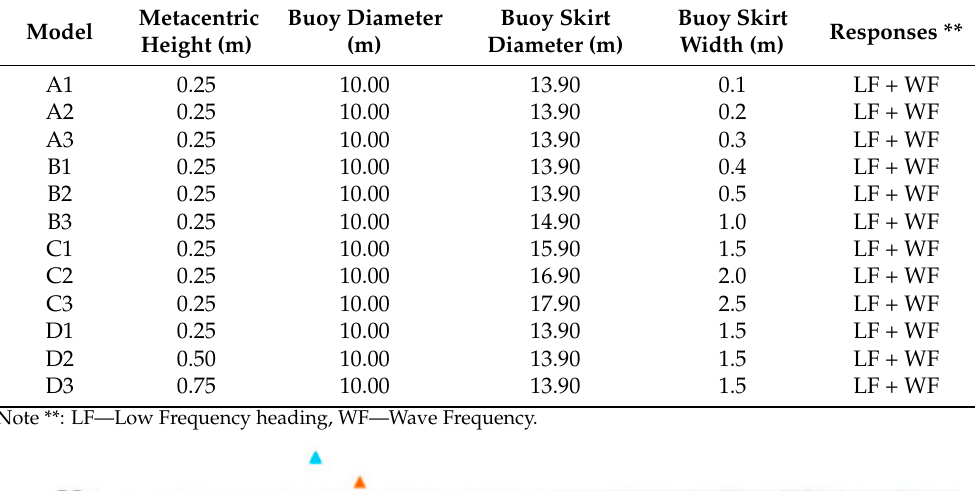
Table 8. Model parameters used in Empirical study for Viscous Damping.